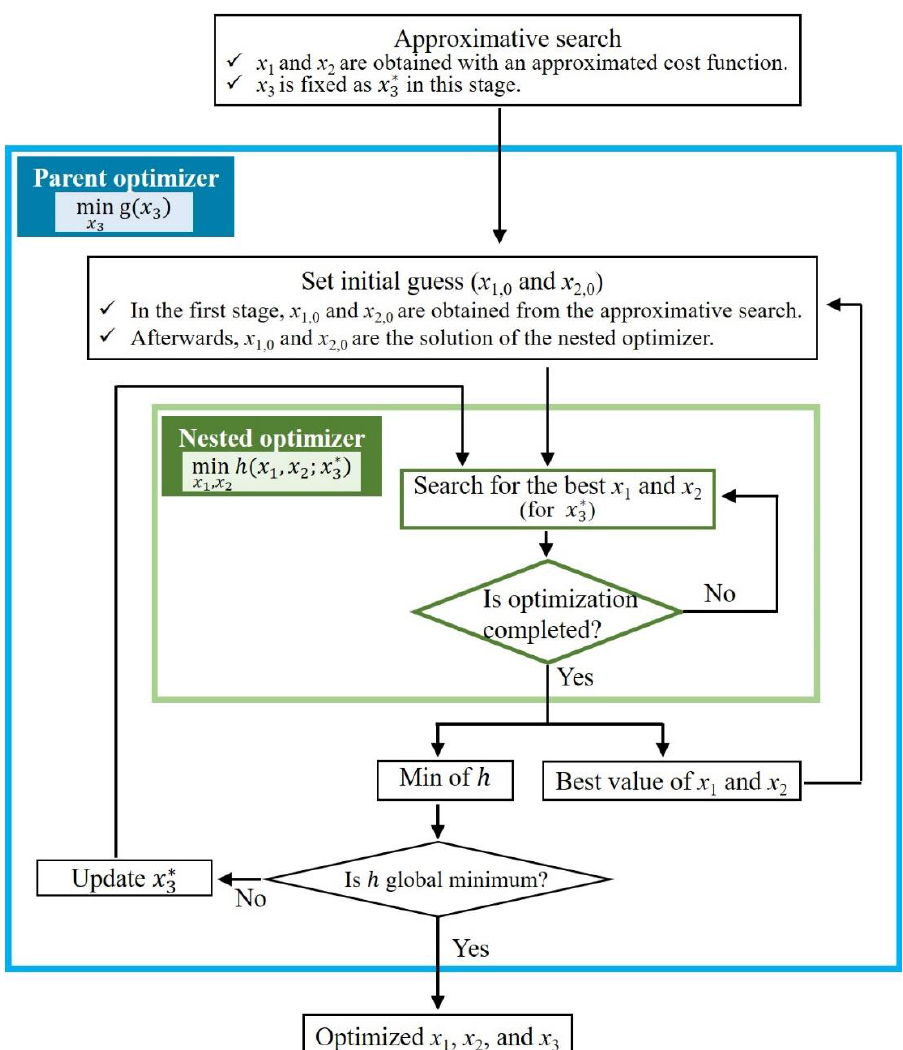
Figure 8. Flowchart of the new optimization approach.